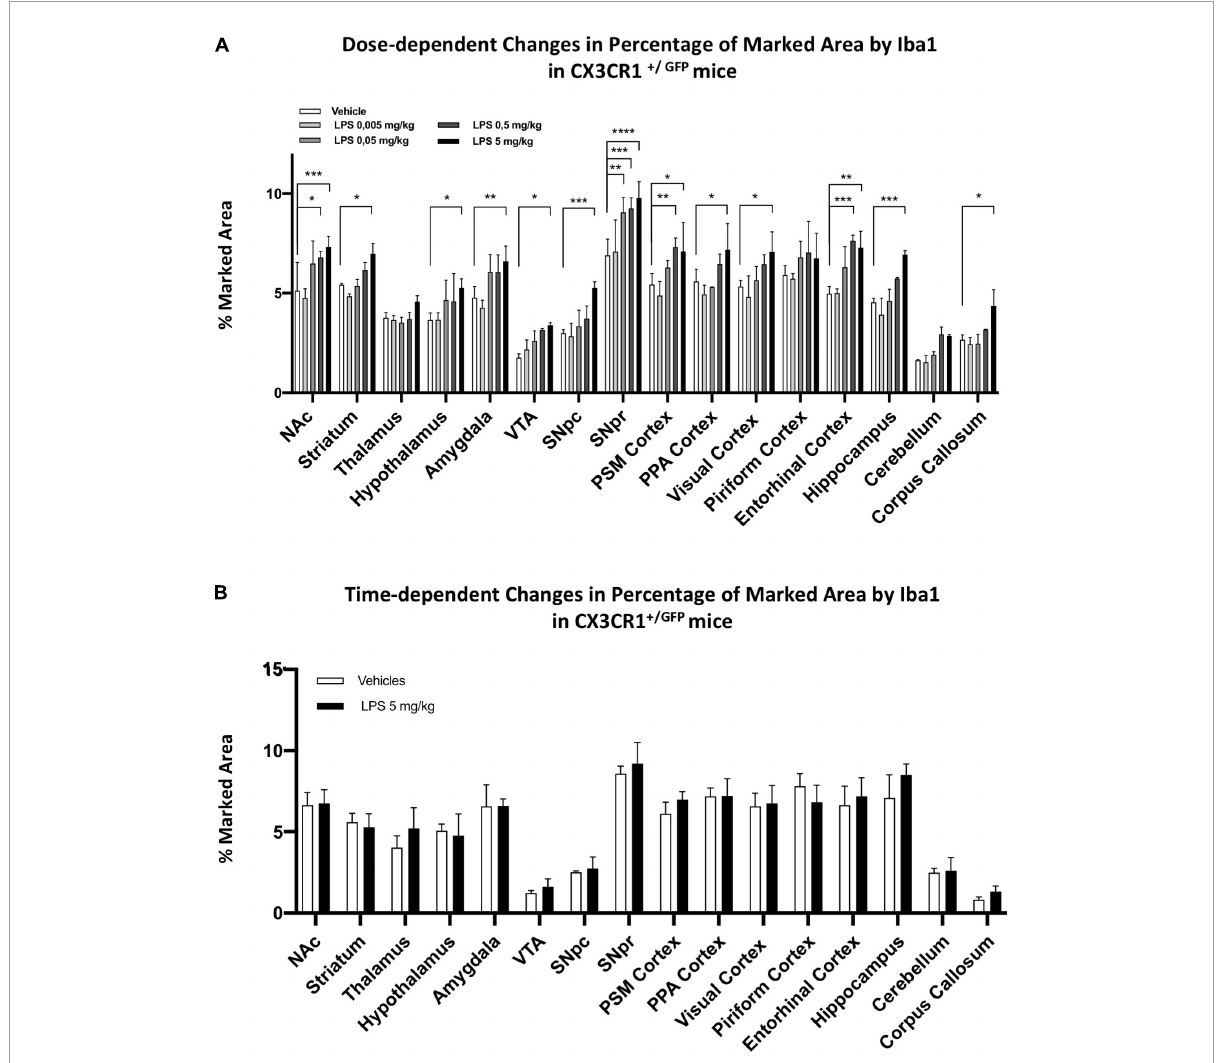
FIGURE7 Dose and time-dependent microglia response in CX3CR1 + / GFP mice. (A) Percentage of marked area by Iba1 in vehicles (white columns), LPS treated mice with 0.005 mg/kg (clear gray columns), 0.05 mg/kg (medium gray columns), 0.5 mg/kg (dark gray columns), 5 mg/kg (black columns) 24 h after treatment. Two-way ANOVA. F BrainRegions (15, 160) = 97.53, p < 0.0001. F Treatment (4, 160) = 77.01, p < 0.0001. F Interaction (60, 160) = 1.219, p < 0,1668, and n = 3 mice per region. Significance: (*) respect relative vehicles. (B) Percentage of marked area by Iba1 in vehicles (white columns) and 5 mg/kg LPS (black columns) 30 days after treatment. Two-way ANOVA. F BrainRegions (15, 160) = 50.73, p < 0.0001. F Treatment (1, 64) = 4.453, p < 0.0388. F Interaction (15, 64) = 0.7369, p < 0.7385, and n = 3 mice per region. Significance: (*) respect relative